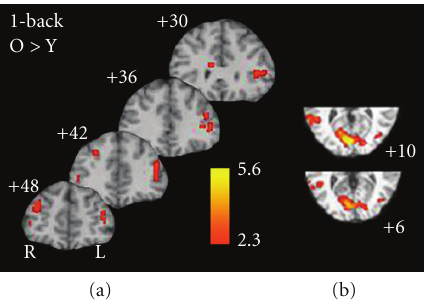
Figure 6: Regions of activation that were di ff erentially greater for older adults on the 1-back (relative to 0-back) compared to younger